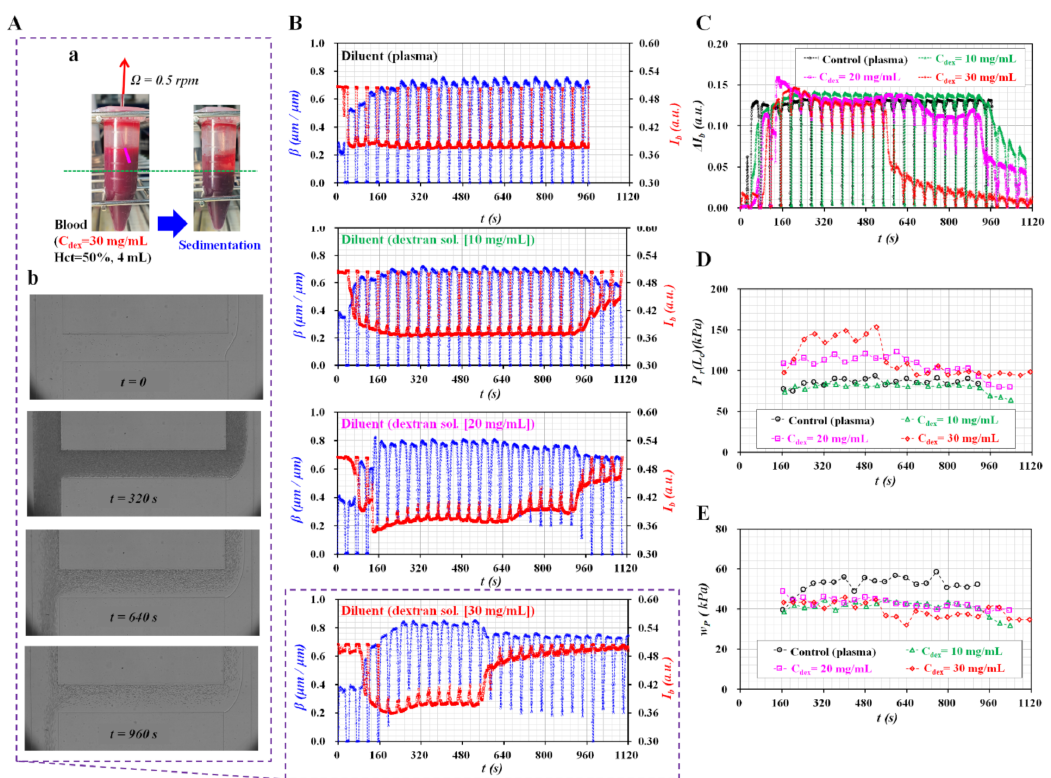
Figure 9. Quantitative evaluation of two properties ( P r , w P ) of blood flow for aggregation-enhanced blood. To enhance RBC aggregation or sedimentation in a tube, blood (Hct = 50%) was prepared by adding normal RBCs into dextran solutions of differing concentrations ( C dex = 10, 20, and 30 mg/mL). Control blood was prepared by adding normal RBCs into plasma. A tube was filled with aggregation-enhanced blood (~4 mL). ( A ) Variations of image intensity due to RBCs sedimentation. (a) diluent and RBCs were segregated because of continuous RBCs sedimentation after a certain time. (b) Microscopic images with an elapse of time ( t = 0, 320, 640, and 960 s). ( B ) Temporal variations of β and I b with respect to C dex . ( C ) Temporal variations of ∆ I b with respect to C dex . The ∆ I b was calculated as ∆ I b = I b ( t = 0)— I b ( t ). ( D ) Temporal variations of P r ( L c ) obtained for each period with respect to C dex . ( E ) Temporal variations of w P with respect to C dex